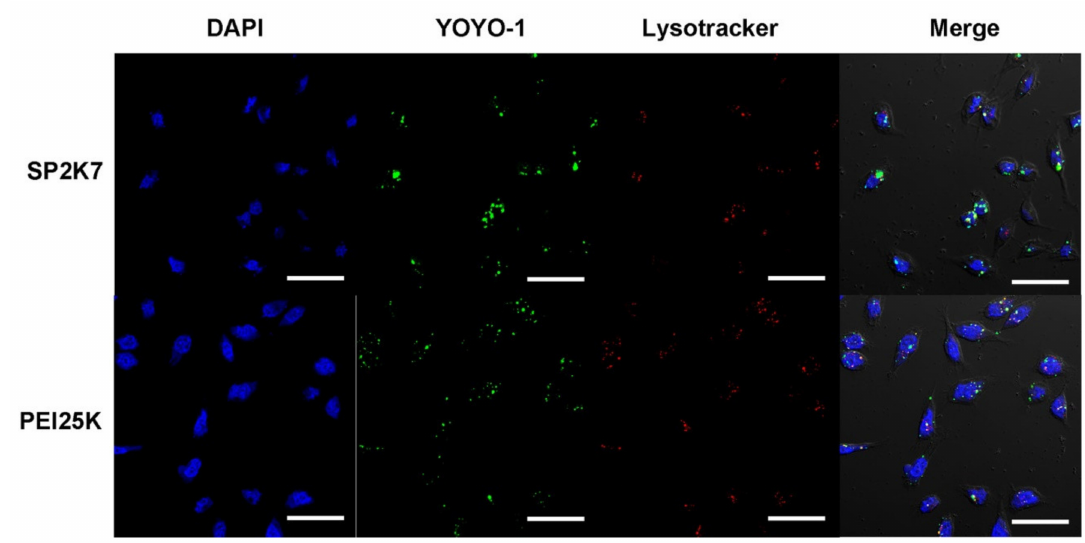
Figure 9. Confocal microscopy observation of SP2K7 polyplexes in HeLa cells (scale bar = 50 µ m). PEI25K was used as a